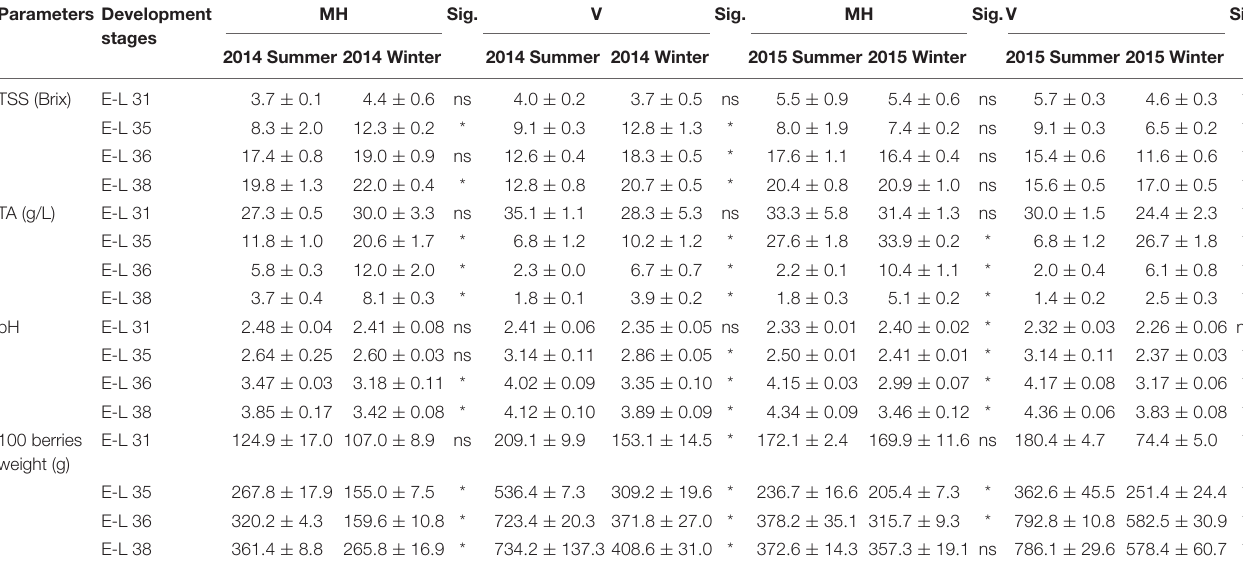
TABLE 2 | Physicochemical parameters of MH and V grapes grown under double cropping system in 2014 and 2015. Parameters Development MH Sig. V Sig. MH Sig.V stages